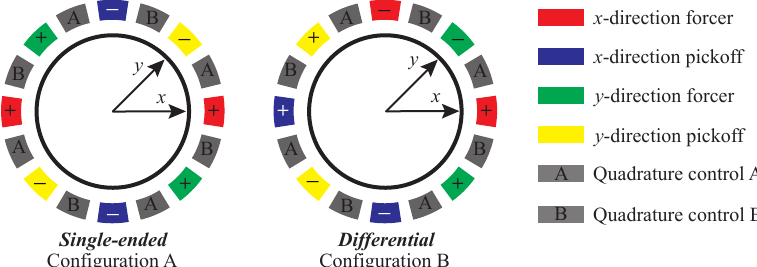
Figure 7. Two electrode configurations for MHRs with 12 actuation electrodes in